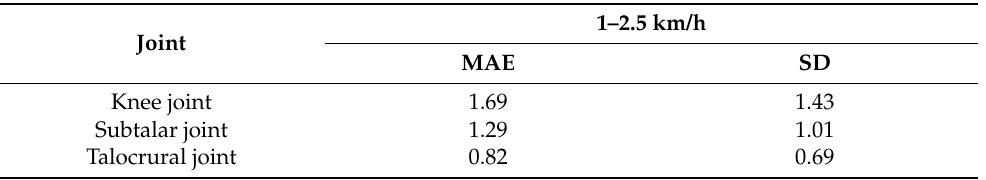
Table 9. The mean absolute error (MAE) and standard deviation (SD) of the angle estimation error according to the walking speed